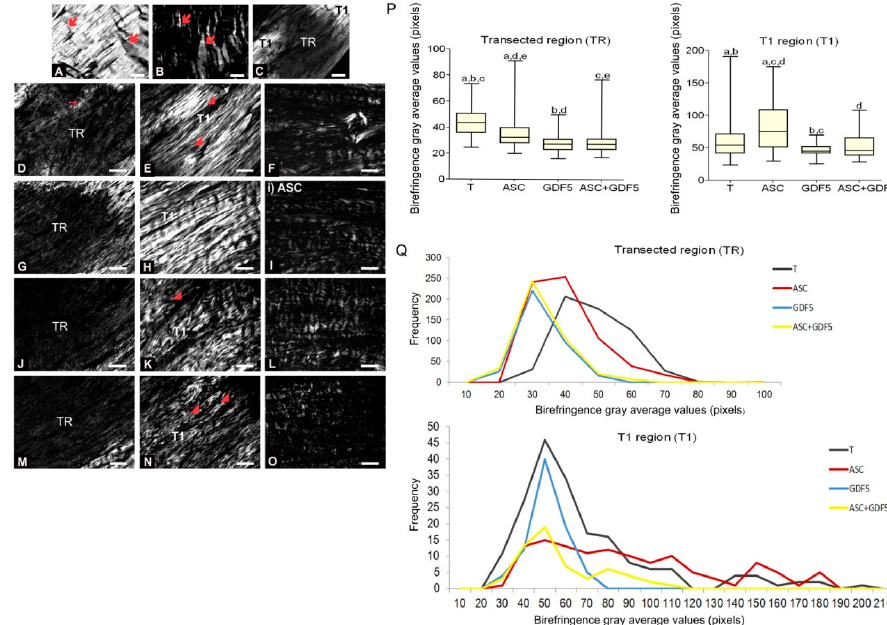
Figure 6. Images of tendons using polarization microscopy. ( A ) group N: Birefringence of the collagen fibers in the proximal region of the calanear tendon. The variation in gray levels is due to the crimp and the degree of aggregation of the collagen fibers ( ); observe the crimp ( B ) by positioning the largest axis of the tendon parallel to one of the polarizers: The same region observed in ( A ). ( C ) Panoramic image of the transected tendon for identification of the transection region (TR) and the proximal and distal transition region (T1). Groups T ( D–F ), ASC ( G–I ), GDF5 ( J–L ), and ASC+GDF5 ( M–O ). Observe the complete disorganization of collagen fibers in TR. The TR from different groups ( D , G , J , M ): Observe freshly formed collagen fibrils and an overlapping ( ) of this region with the thicker fibers present in T1. T1 ( E , H , K , N ): Collagen fibers with a greater organization in relation to TR, however, with fragmentation presence ( ) mainly in groups T ( E ), GDF5 (K), and ASC+GDF5 (N). Crimp ( F , I , L , O ) from the collagen fibers observed on T1: Observe similar undulation patterns of the collagen fibers between the groups, represented by light and dark regions. The largest axis of the tendon was positioned at 45° in relation to the crossed polarizers as parallel to one of the polarizers ( B , F , I , L , O ). ( P ) TR birefringence measurements in T1: Same letter represents significant differences between groups ( p ≤ 0.05). ( Q ) Histogram of the frequency and birefringence values showing differences in the distribution of values in the different groups. Bars = 100 μ m and 200 μ m (a).